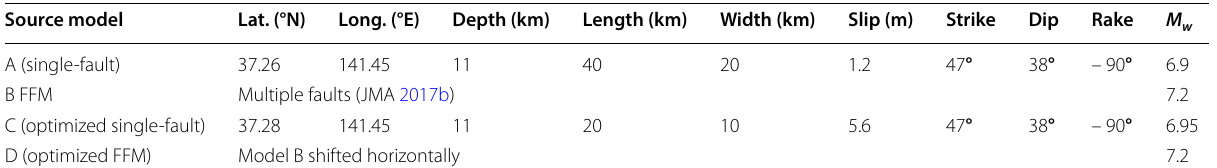
Table 2 Model fault parameters